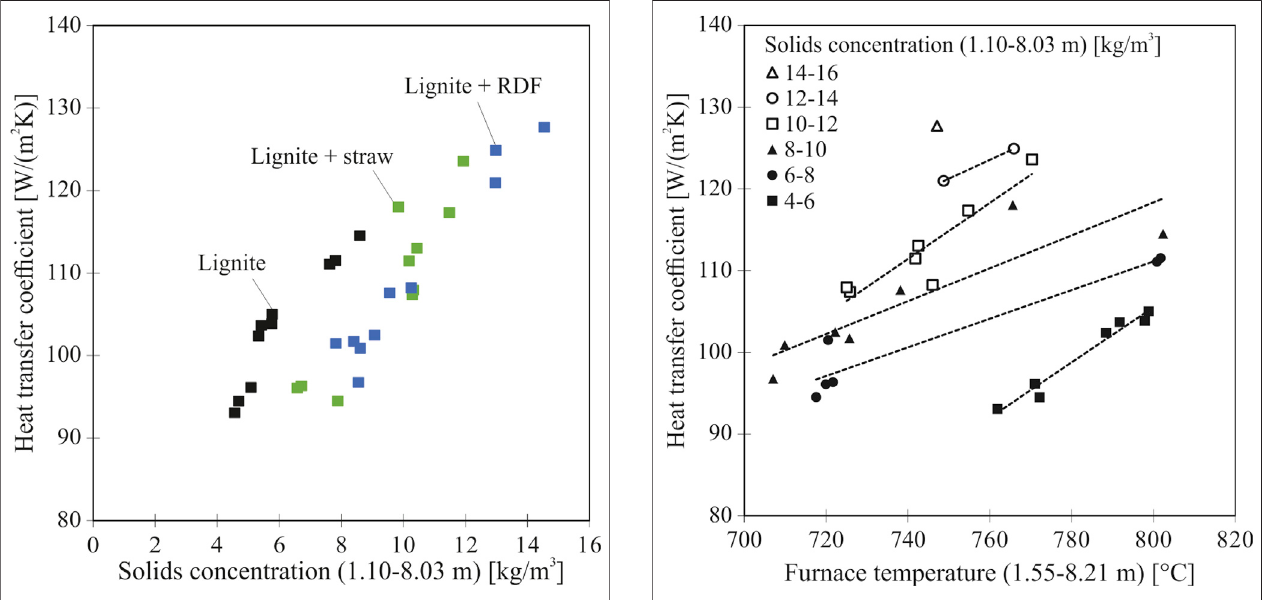
FIGURE 5 | Heat transfer coef fi cient vs. solids concentration. FIGURE 6 | Heat transfer coef fi cient vs. upper furnace